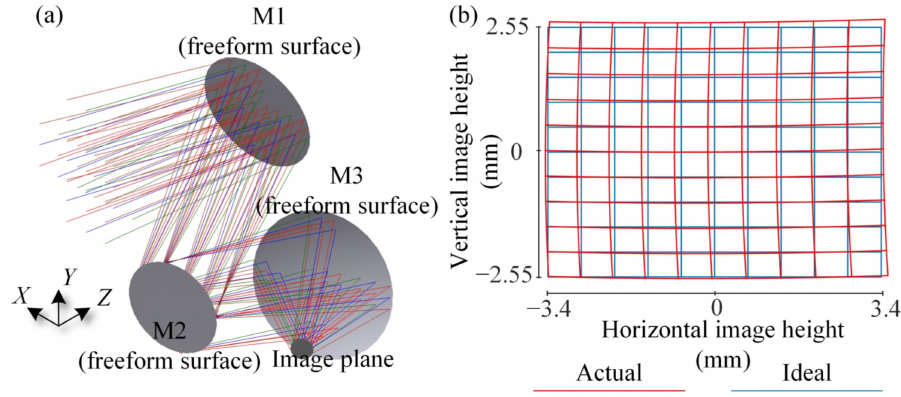
Figure 6. ( a ) The layout of the initial freeform system. ( b ) The distortion grids. During the optimization process, the full FOV must be sampled. In our work, we selected (0 ◦ , 0 ◦ ), (0 ◦ , − 3 ◦ ), (0 ◦ , 3 ◦ ), (4 ◦ , 0 ◦ ), (4 ◦ , − 3 ◦ ), (4 ◦ , 3 ◦ ), ( − 4 ◦ , 0 ◦ ), ( − 4 ◦ , − 3 ◦ ), and ( − 4 ◦ , 3 ◦ ) as the nine field angles to be used in the optimization process, and these angles are consistent with the sampled field angles in the starting point solving process. The distances between the intersections of the chief rays of fields (4 ◦ , − 3 ◦ ), (4 ◦ , 3 ◦ ), ( − 4 ◦ , − 3 ◦ ), and ( − 4 ◦ , 3 ◦ ) with the image plane and the intersection of the chief ray of field (0 ◦ ,0 ◦ ) with the image plane were set as the constraints for the image height to control the focal length and distortion. Early in the optimization process, the surface position, the radii,